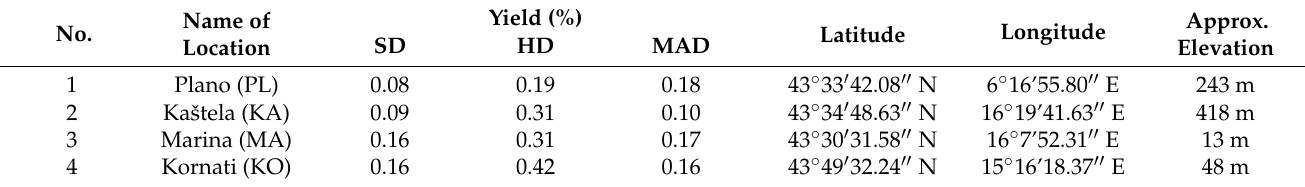
Figure 1. Acquisition and preparation of plant material for distillation purposes; ( A )—wild-growing immortelle ( H. italicum (Roth) G. Don) in its natural environment, ( B )—dried and cut material after homogenization. Table 1. Location and yield of essential oils H. italicum (Roth) G. Don.